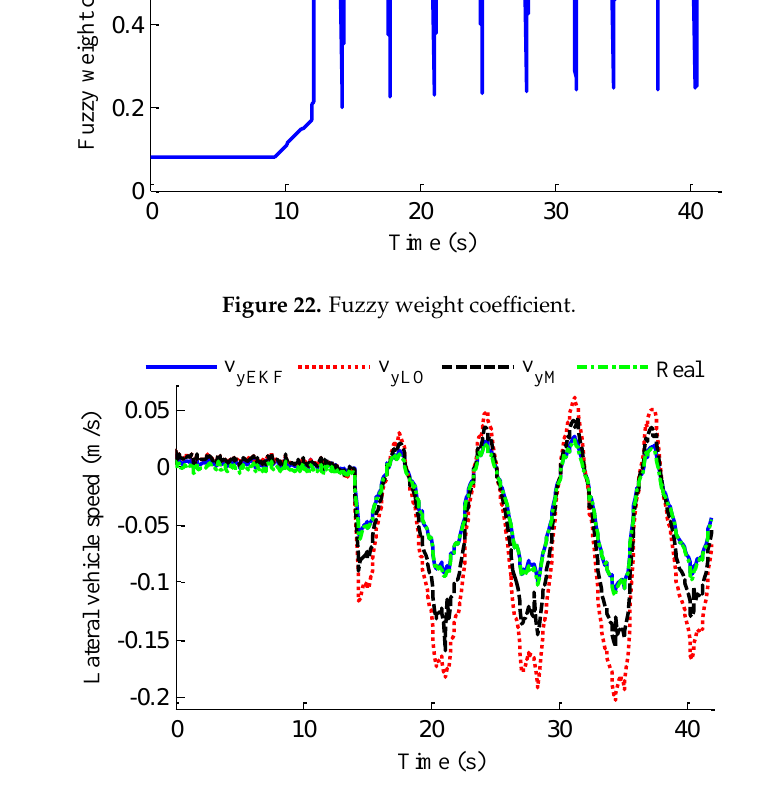
Figure 23. Estimation of lateral vehicle speed.